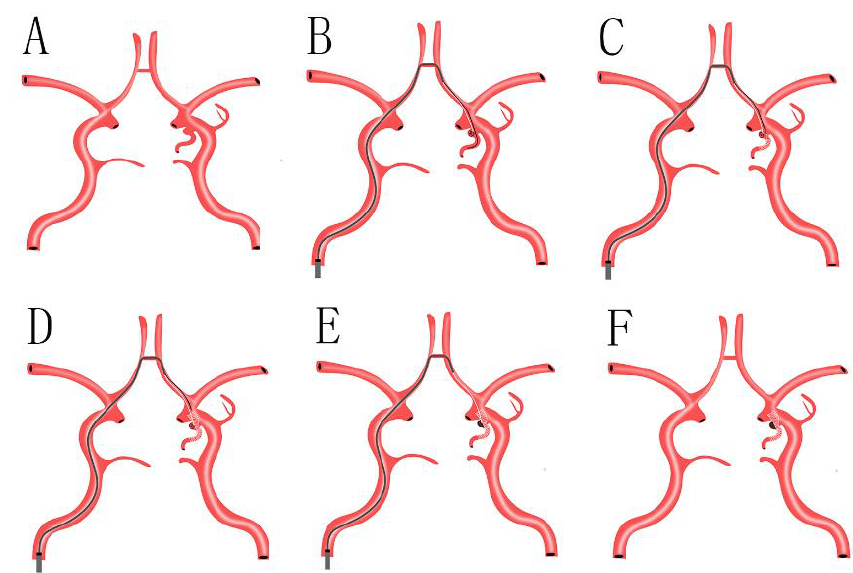
Figure 1. ( A ): A suitable stent was selected, according to the precise aneurysmal measurements and the diameter of parent arteries, as assessed by intraprocedural DSA; ( B ): a suitable stent microcatheter was navigated to the ipsilateral PCoA, and a suitable coil microcatheter was navigated to the aneurys- mal lumen and transported several coils loosely, via the contralateral ICA and ACA and ipsilateral ICA; ( C ): the stent microcatheter was withdrawn, and the stent was gradually released in the ipsi- lateral PCoA; ( D ): the stent microcatheter was withdrawn continuously until the stent covered the aneurysmal neck and was released in the dismal segment of the ipsilateral ICA completely; the good wall apposition of the stent was confirmed by intraprocedural DSA, and was used to remove the stent microcatheter from the guiding catheter; ( E ): to transport several coils via a suitable coil microcatheter with the assistance of the stent, and to accomplish the complete occlusion of an aneurysm confirmed by intraoperative DSA; ( F ): to withdraw the coil microcatheter and guiding catheter from the